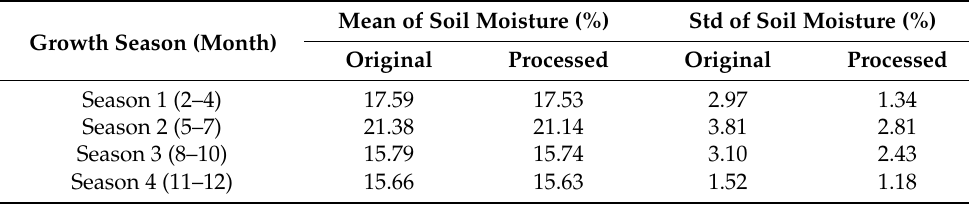
Table 1. Statistical analysis results of original and processed soil moisture data.